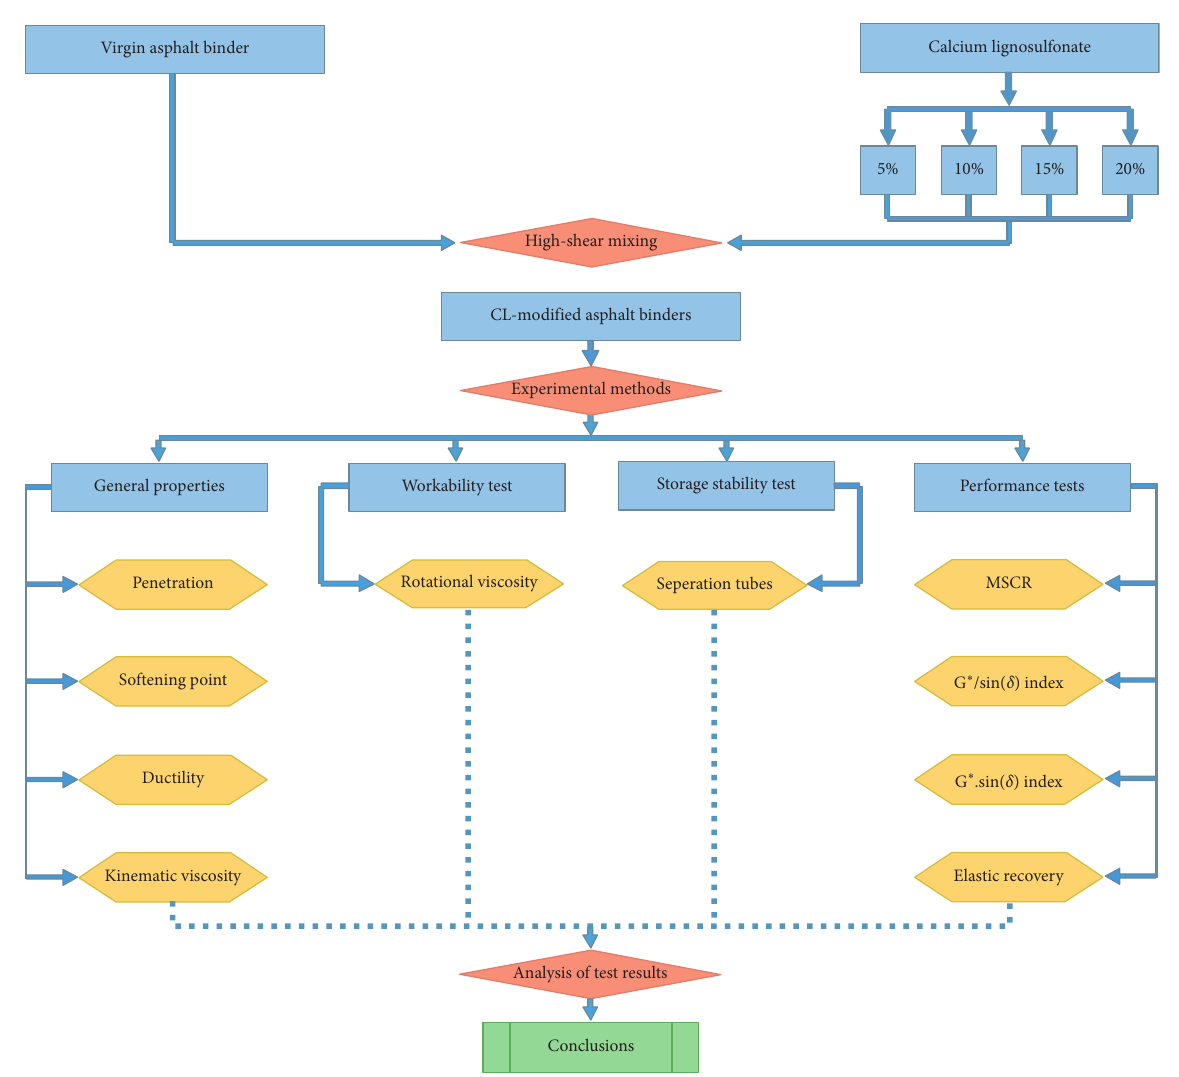
Figure 1: Experimental plan scheme.